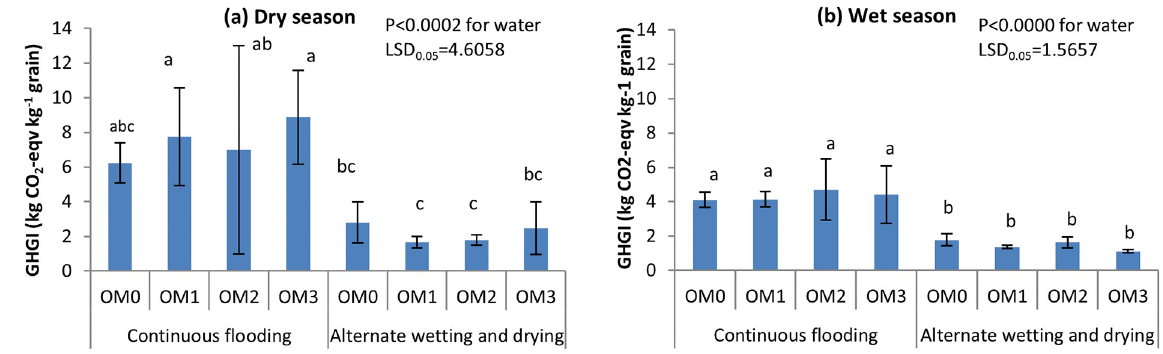
Fig 11. Effect of water and cow dung manure management on greenhouse gas intensity of potted rice during dry (a) and wet (b) seasons, 2017. OM